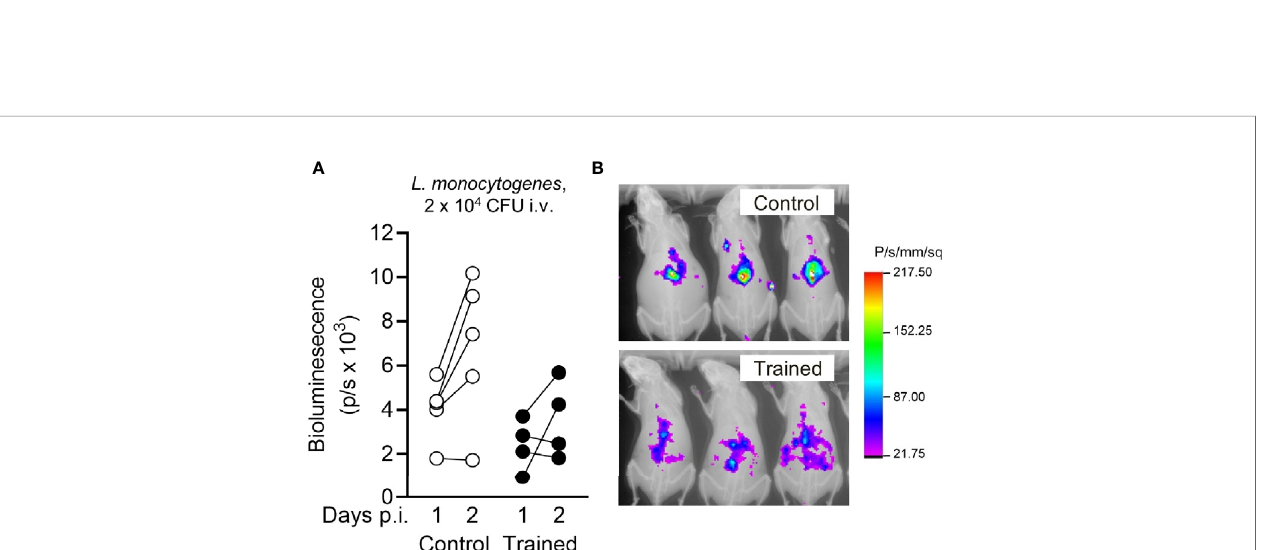
FIGURE 5 | Training for 9 weeks increases the metabolic activity of PMNs and monocytes. PMNs and monocytes were isolated from the bone marrow of control mice and mice trained 9 weeks before analysis ( n = 4 mice per group). One hundred fi fty thousand PMNs (A – D) and monocytes (E – H) were incubated for 30 min with or without 10 8 heat-killed L monocytogenes before measuring glycolytic activity (A, E) and mitochondrial respiration (C, G) . Glycolytic activity was determined using Glycolytic Rate kit, with consecutive injections of 0.5/0.5 m M Rot/AA (rotenone/antimycin A) and 50 mM 2-DG (2-deoxyglucose). Glycolytic activity is depicted by means of proton ef fl ux rate (PER) adjusted to protein concentration per condition. Mitochondrial respiration was analyzed using Mito Stress kit, with consecutive injections of 1 µM oligo (oligomycin), 2 µM FCCP and 0.5/0.5 m M Rot/AA. Mitochondrial respiration is depicted by means of oxygen consumption rate (OCR) adjusted to protein concentration per condition and represented as OCR. (B, F) Basal glycolysis ( i.e. last PER measurement before the fi rst injection) expressed by the PER in pmol/min. (D, H) Basal respiration ( i.e. energetic demand of the cell under baseline conditions) expressed by the OCR in pmol/min. Data are means ± SEM from 4 mice analyzed in quadruplicate. Each dot in the violin plots represents data from one individual mouse.